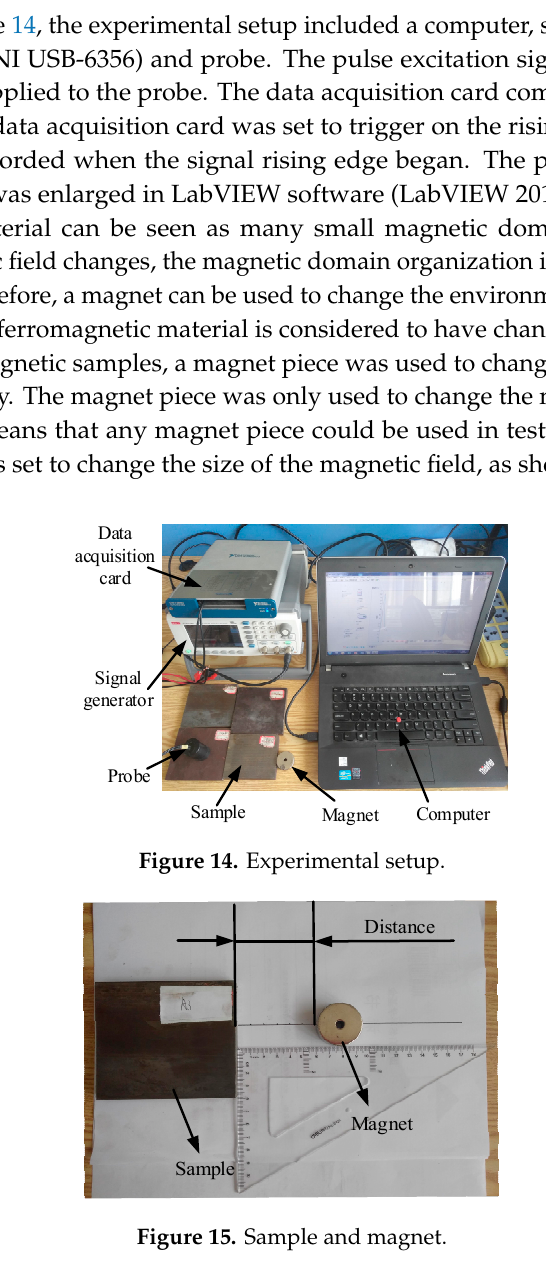
Table 1. Conductivity of experiment samples.